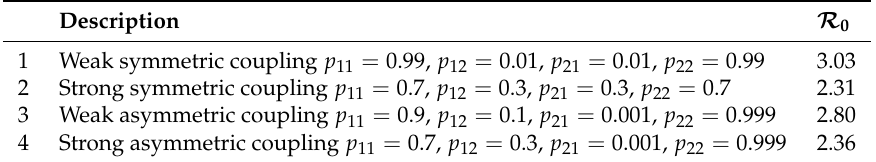
Table 2. Association between the basic reproduction number and the residence-time